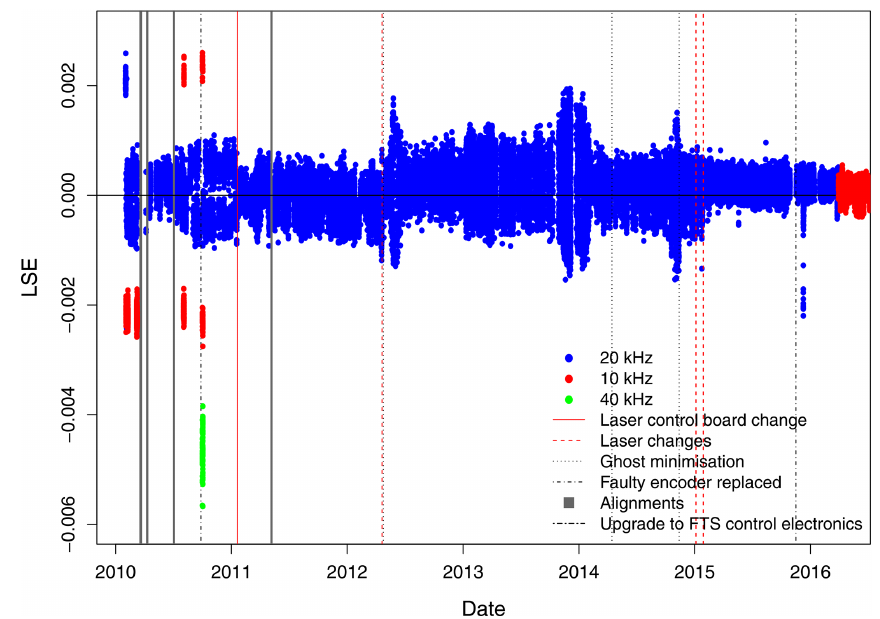
Figure 1. Time series of LSE calculated using the I2S algorithm for the IFS 125HR spectra. For 20kHz data only every 10th data point is plotted for clarity. Vertical lines show significant changes or adjustments to the